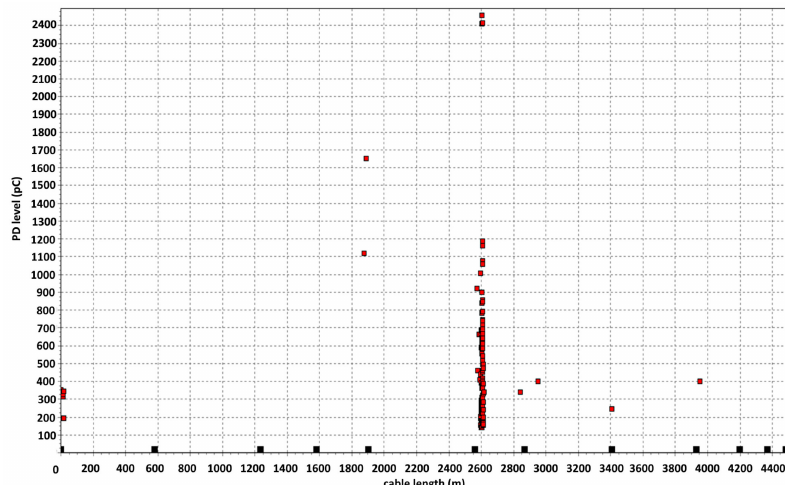
Figure 4. Monitored voltages withstand testing of a 150 kV XLPE cable underground circuit (4.5 km) up to 1.7 Uo . Example of PD mapping as obtained during DAC voltage testing up to 1.0 Uo shows that joint No. 5 has concentrated PD activity at operating voltage